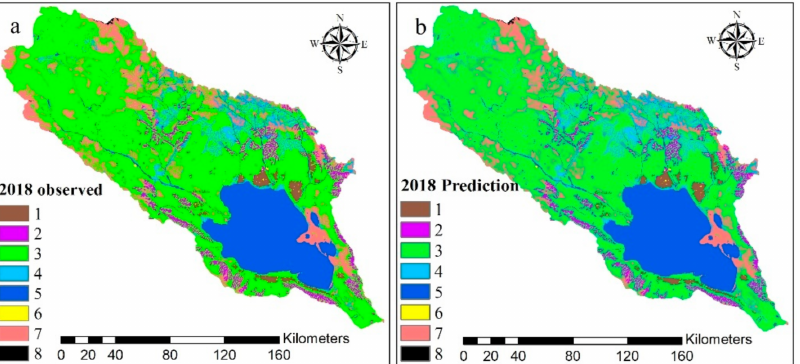
Figure 4. Observed ( a ) and predicted ( b ) LULC maps for 2018. 1—cropland,